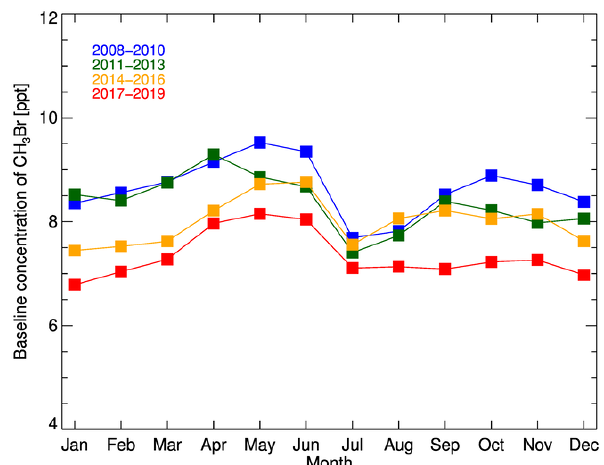
Figure 3. Monthly mean CH 3 Br baseline mole fractions at Gosan for 2008–2019. Each color represents the average of the 3-year in- terval for the period. Note that there are data missing for several months in 2016, 2017, and 2018, mainly due to typhoon damage to Gosan station and repair of